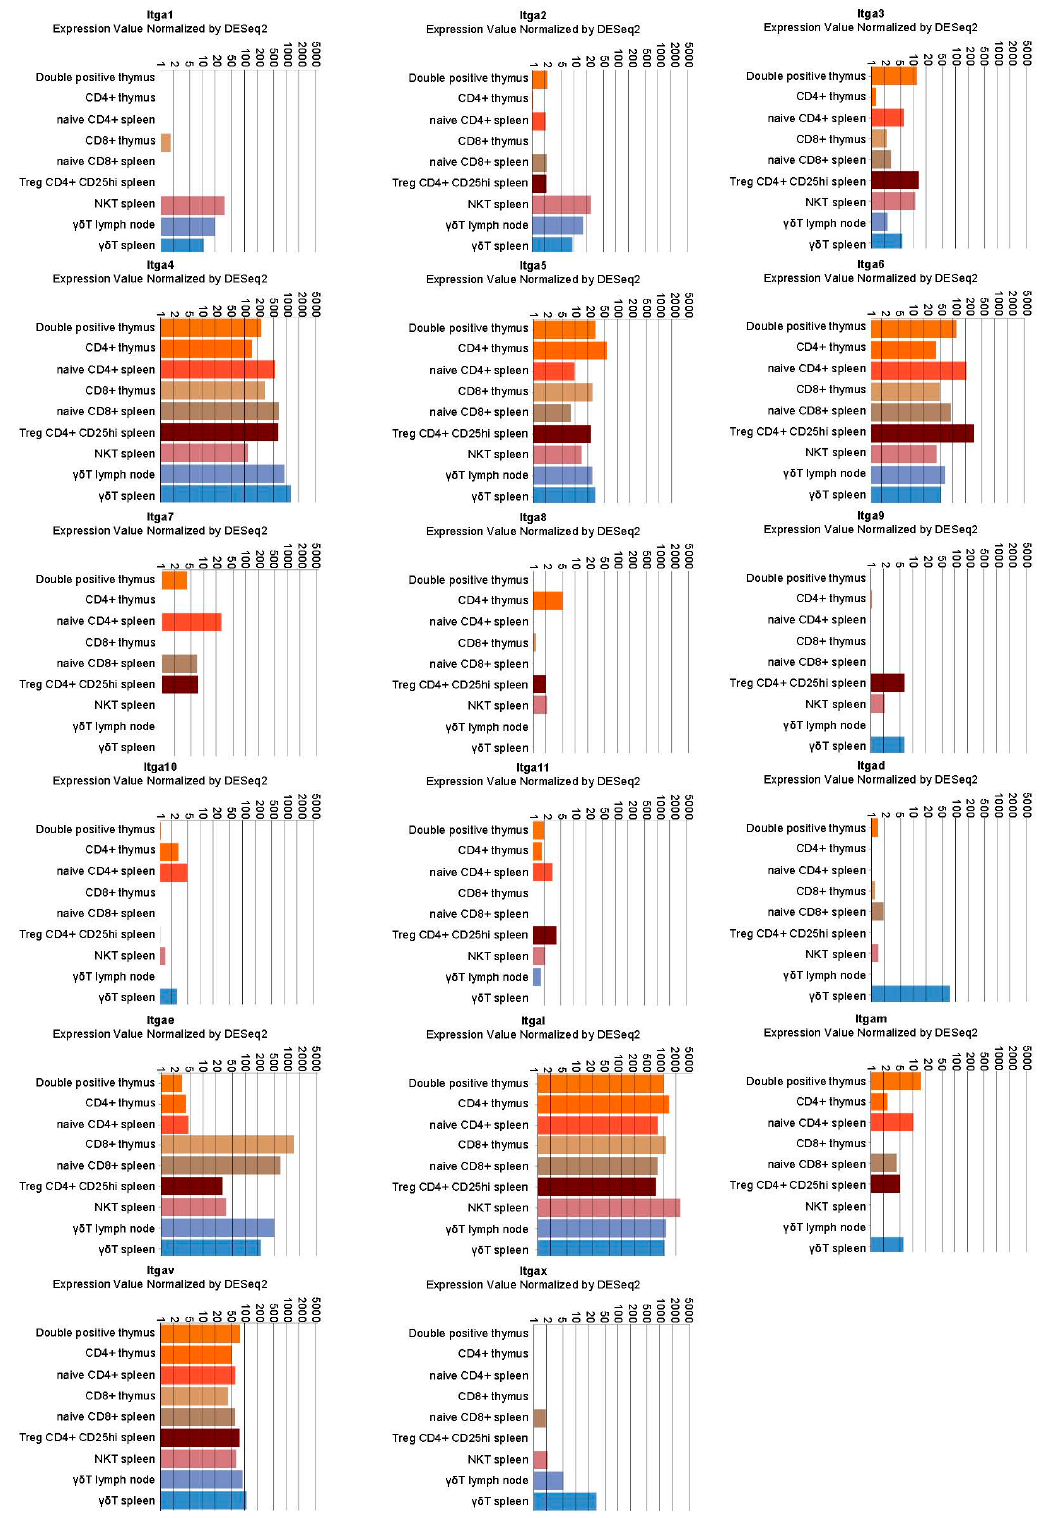
Figure 1. Integrin α chain expression in selected lymphocyte populations. Data were retrieved by the immunological genome project (Immgem ULI RNAseq database, Geo accession: GSE109125) using the RNA-seq Skyline tool and plotted in global scaling (log10) [5]. Treg: regulatory T cells; NKT: natural killer T cells; γδ T: γδ T cells.